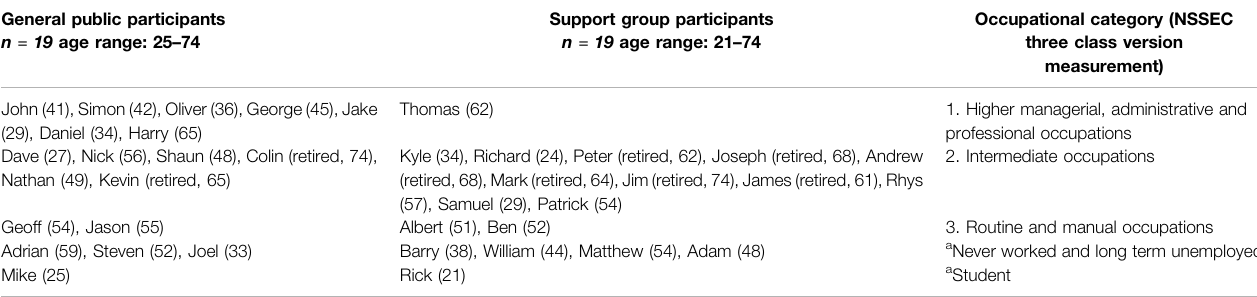
TABLE 1 | Sample groups and